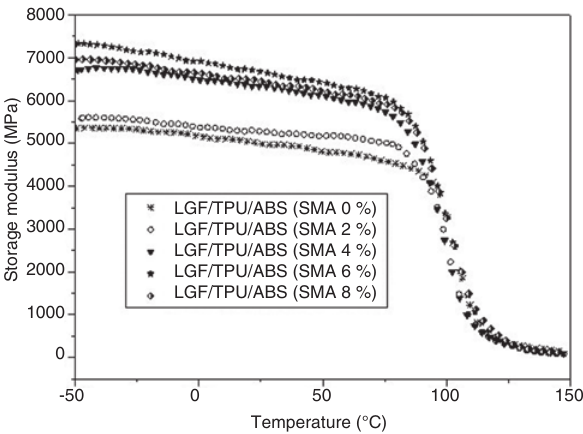
Figure 3 Effects of compatibilizer content on storage modulus of the